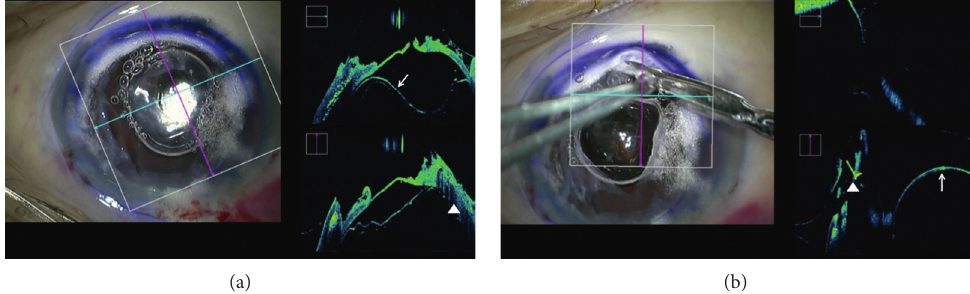
Figure 2: MIOCTimages of DALK case. (a) Descemet membrane detachment. MIOCTshows cross-sectional images of both the Descemet membrane (arrow) detachment and the lamella dissected by air (arrow head). (b) Removal of the residual corneal stroma with scissors. The location between the Descemet membrane (arrow) and the scissors (arrow head) is roughly displayed by MIOCT, which contributes to the prevention of Descemet membrane rupture by preventing unintentional contact of the tip of scissors with the